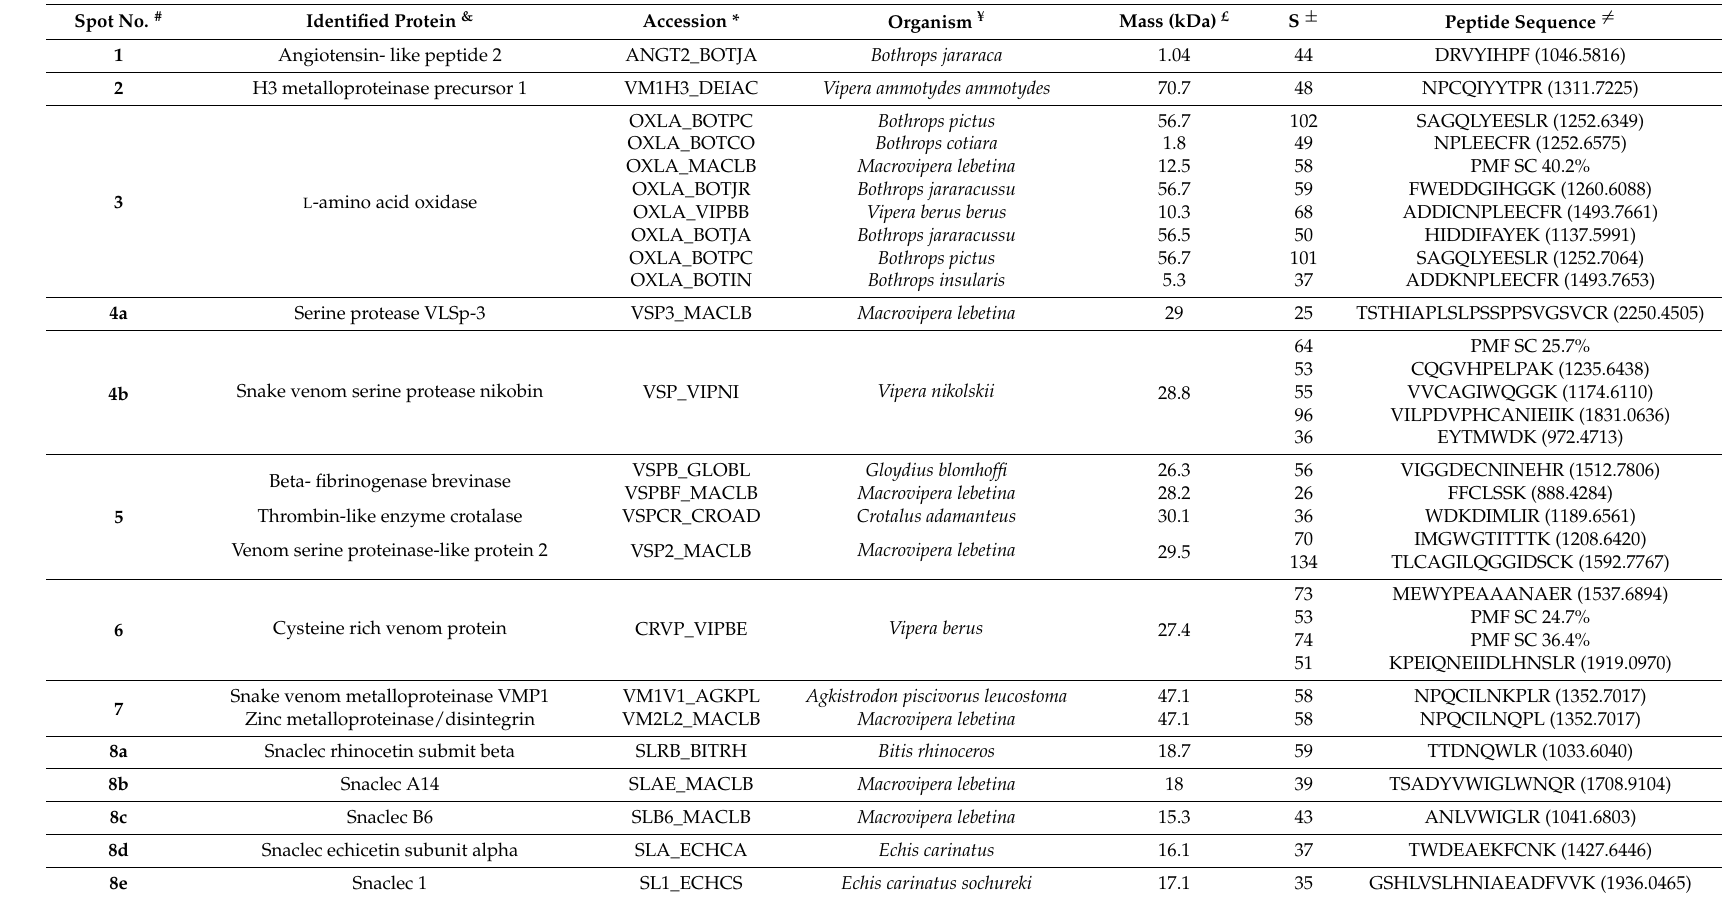
Table 1. Composition of V. berus berus venom